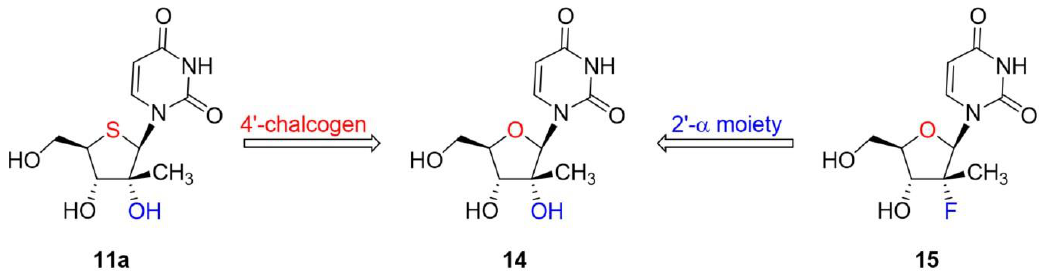
Figure 3. Comparison of the structural features of the most potent nucleoside of this work ( 11a ) to sofosbuvir ( 15 ), with the bridging structure of 2′-β-methyluridine ( 14 ).